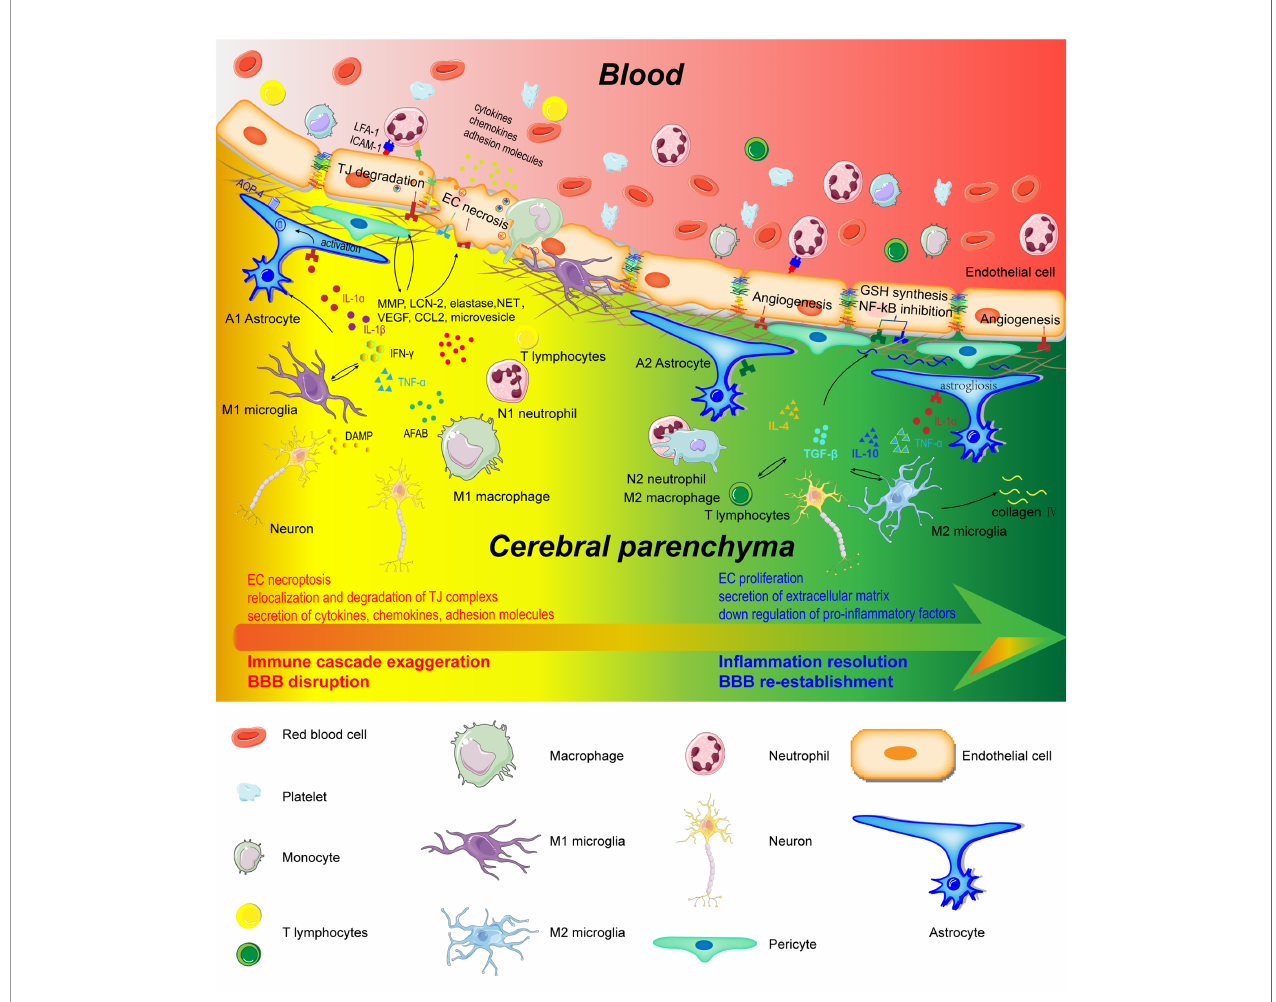
FIGURE 2 | Schematic representation of cerebral and peripheral immune cells regulating BBB integrity during early and later phases of ischemic stroke. In fi ltrated neutrophils produce proteases (MMPs, proteinase 3, and elastase), lipocalin-2, NET, microvesicles, cytokines, and chemokines to destroy the BBB structure. M1- type monocytes secret cytokines and chemokines to degrade TJs. Perivascular microglia phagocyte ECs, which directly lead to endothelial dysfunction and BBB disintegration. In addition, M1 microglia disrupt BBB integrity through the production and secretion of pro-in fl ammatory factors (IL-1 a , IL-1 b , IL-6, TNF- a , IFN- g , and CCL2), MMP9, and VEGF. A1 astrocytes directly exert deleterious effects on BBB through increasing VEGF, cytokines (IL-1 b , IL-6, and TNF- a ), chemokines (CCL2 and CCL5), MMP, and LCN-2. However, in the recovery phase of AIS, these immune cells contribute to in fl ammation resolution and BBB re-establishment. N2 neutrophils promote engulfment of neutrophils by macrophages and in fl ammation resolution. Monocyte-derived M2 macrophages facilitate the expression of collagen IV and efferocytosis. Microglia directly protect BBB integrity through the secretion of IL-10 and TGF- b . A2 astrocytes are capable of secreting IL-2, IL-10, and TGF- b to accelerate in fl ammation